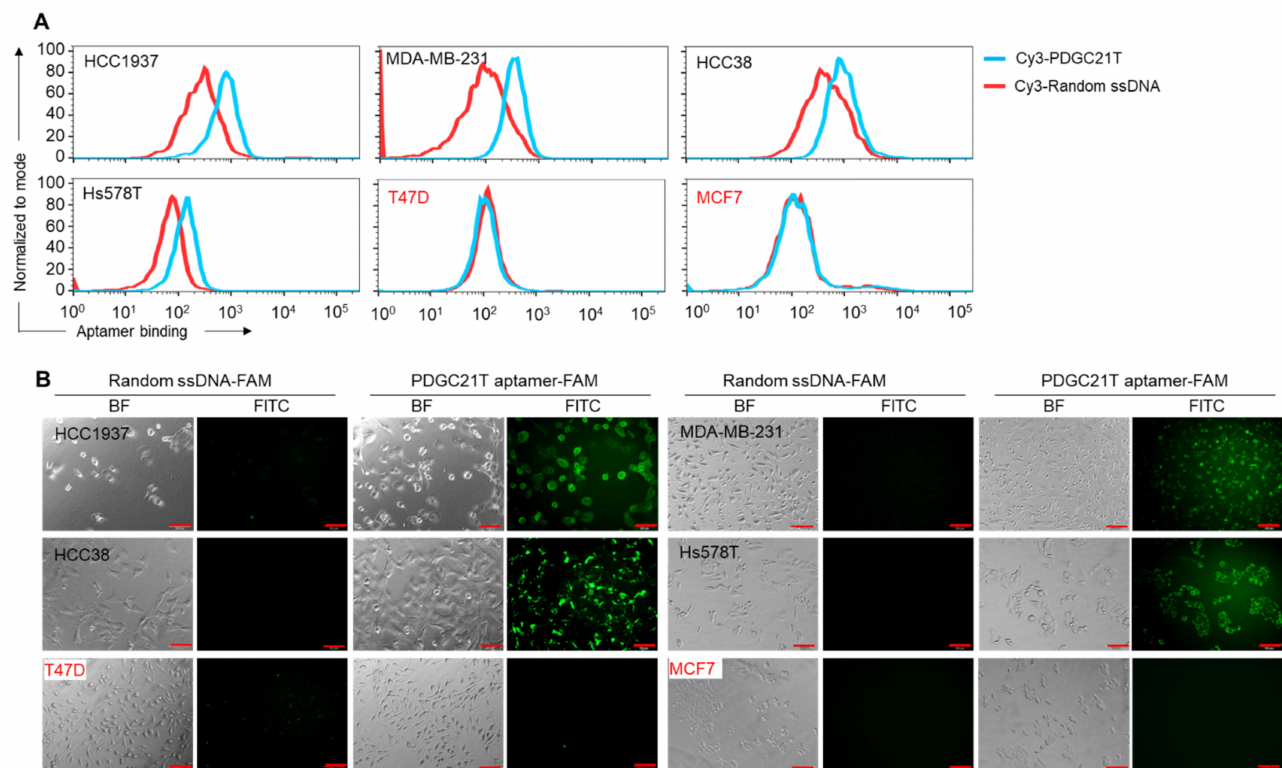
Figure 1. Specific binding of the PDGC21T aptamer to cultured triple-negative breast cancer (TNBC) cells. ( A ) Flow cytometry analysis demonstrates that PDGC21T aptamer binds to suspended TNBC cells but does not react with non-TNBC cells. ( B ) Fluorescent microscopy confirmed that PDGC21T binds to adherent TNBC cells but does not react with non-TNBC cells. Red font indicates non-TNBC cell line. BF; bright field, FITC; fluorescein isothiocyanate. Scale bars = 100 µ m. The final incubation concentration of aptamers or random ssDNA was 200